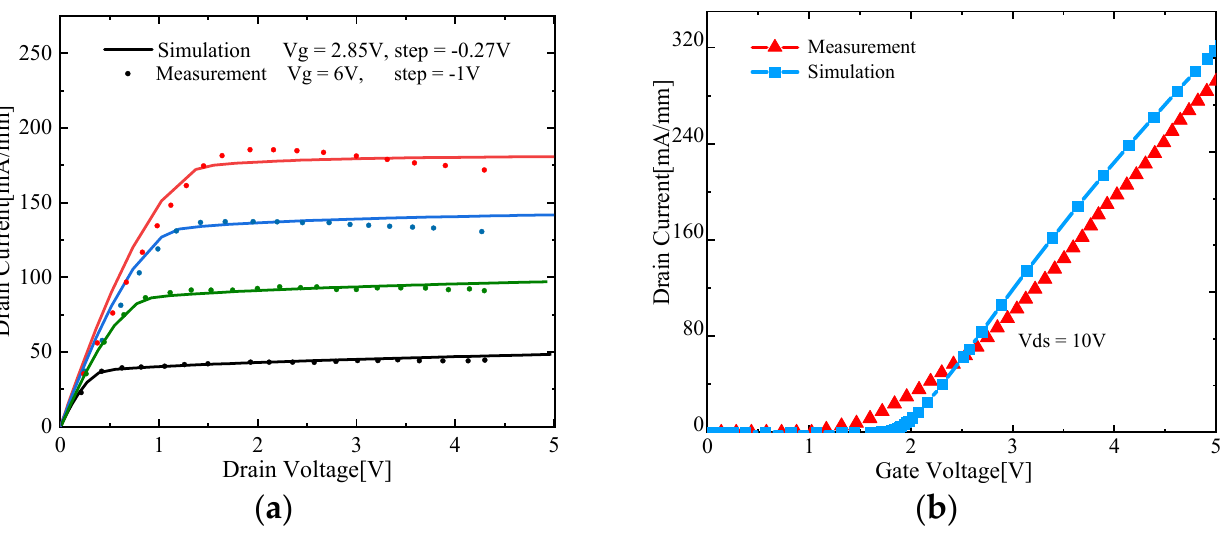
Figure 2. ( a ) Simulation and measurement comparison in output characteristic (simulation—solid line; measurement—dotted line); ( b ) transfer characteristic (simulation, blue line; measurement, red line).